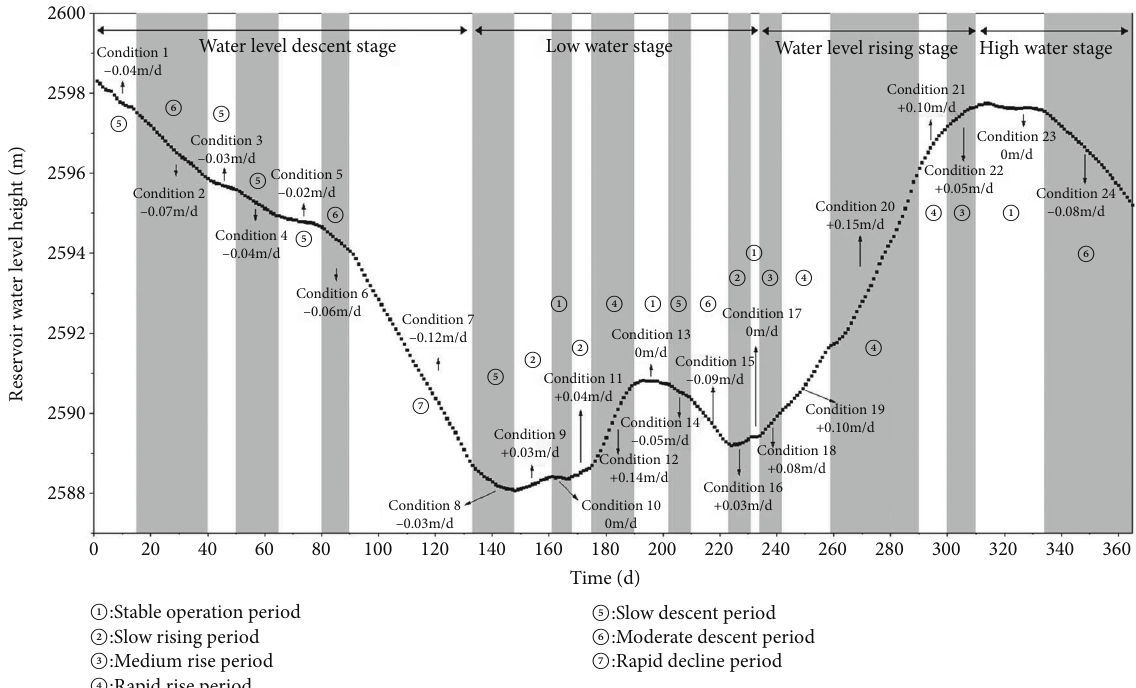
Figure 6: Water level fl uctuation of Longyangxia Hydropower Station and selection of working conditions in